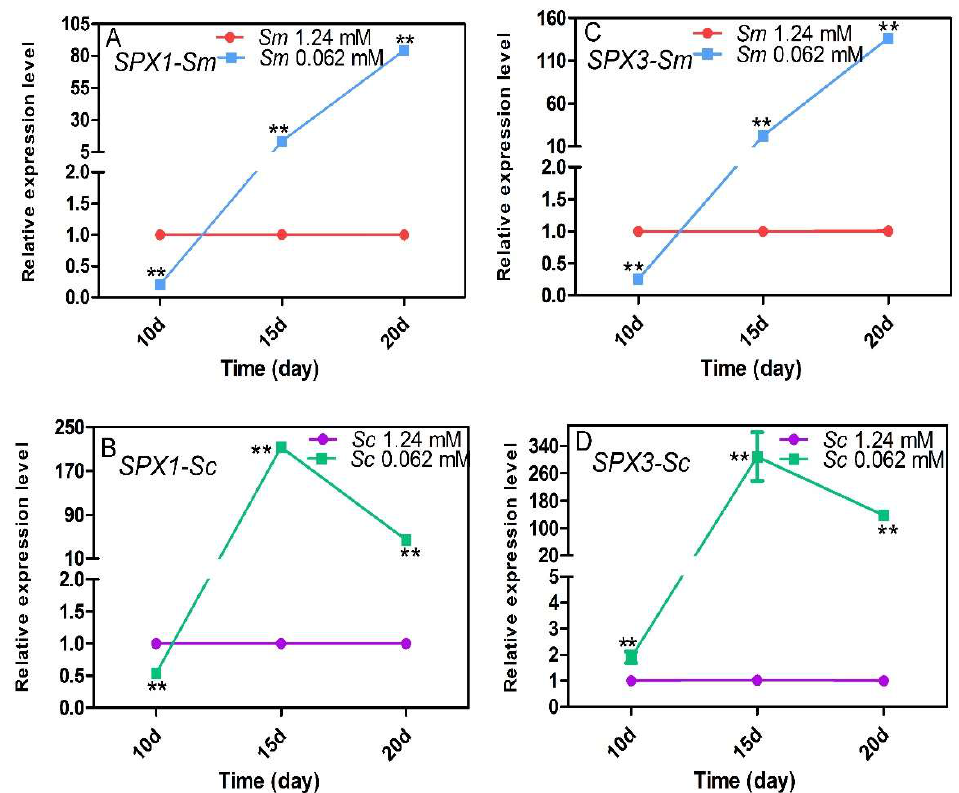
Figure 4. Expression of SPX1 and SPX3 in S. miltiorrhiza ( A , C ) and S. castanea ( B , D ) under control and Pi-deficient conditions. Quantification of the transcript levels of SPX genes were calculated in relation to β -actin reference gene transcript levels. Sm , S. miltiorrhiza ; Sc , S. castanea ; SPX , Syg1-Pho81-Xpr1 . The double-asterisk “**”represents p < 0.01 compared to the control Pi value and obtained via Student’s t -test by SPSS.